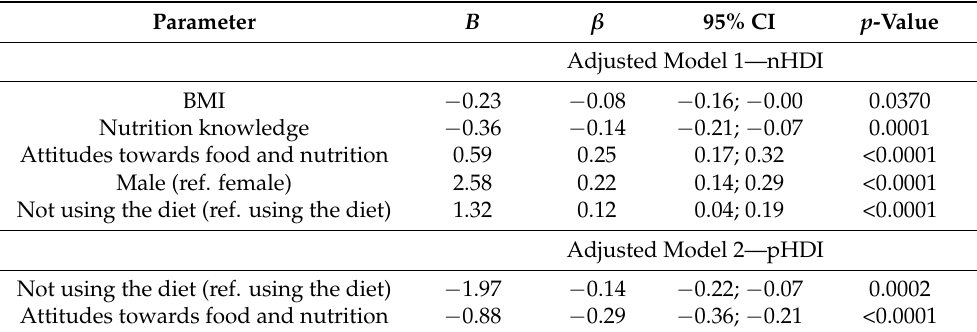
Table 7. Multiple linear regression analysis of nHDI and pHDI in the study